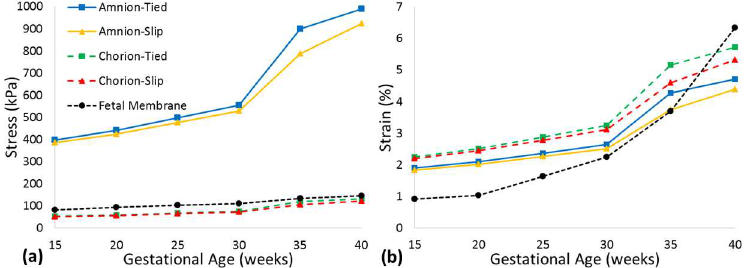
Fig 3. Predicted maximum principal(a) stress and (b) strain in the chorionand amnion membranes, comparing tied and slip contact conditionswith a singlefetal